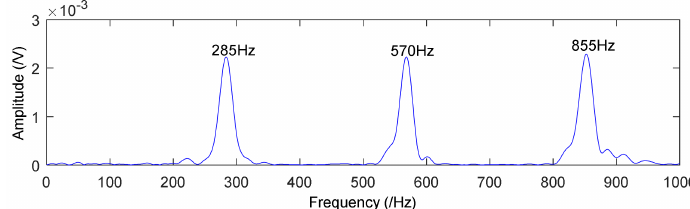
Figure 34. The diagonal slice spectrum after noise reduction using multiscale local